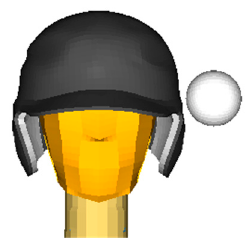
Figure 2. Baseball impact simulation using the Hybrid III head finite element (FE) model to identify material properties of the helmet model.